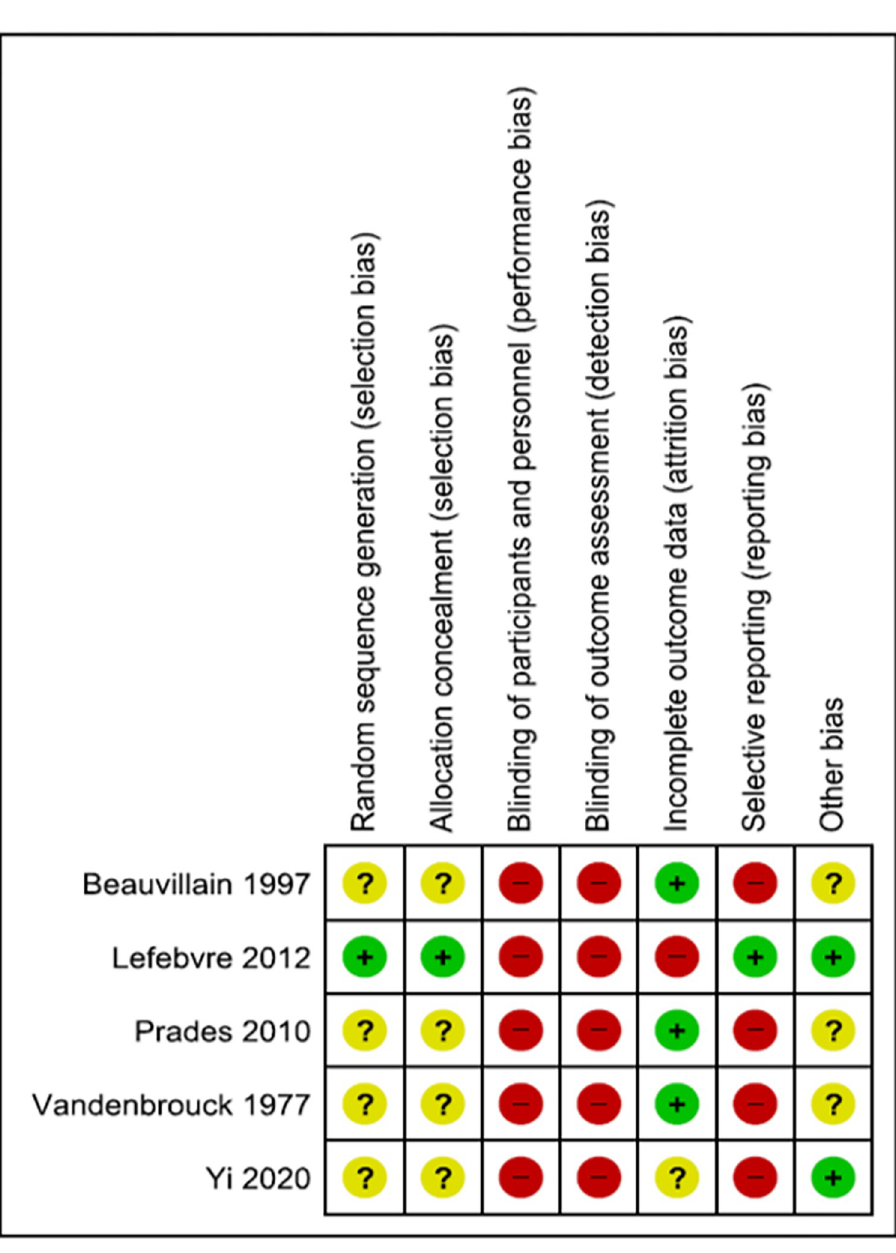
(LFS). There was no statistically significant differences in overall survival, laryngectomy-free